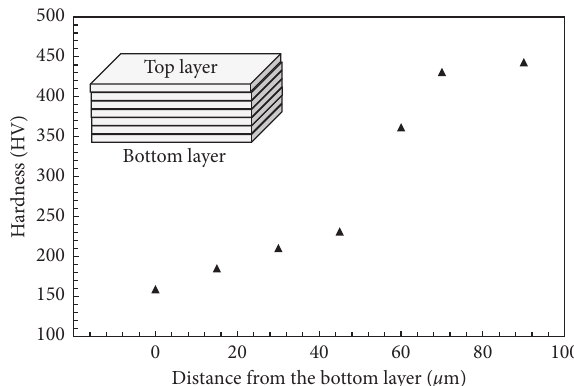
Figure 9: Hardness profile of the UAM laminate after the SPS treatment (drawn from